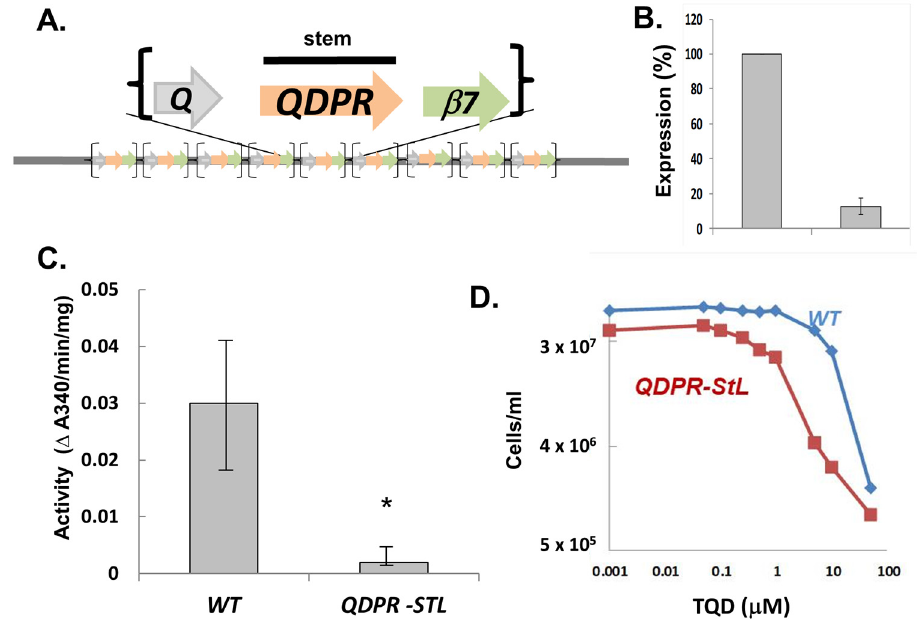
Figure 3. RNAi of the tandemly dispersed gene QDPR .( A ) QDPR gene organization in L. braziliensis . QDPR genes are tandemly repeated with ORFq ( Q ) and β 7 proteasome ( β 7 ) up to 9 times in L. braziliensis genomes; only the ORFs are depicted, and the entire QDPR ORF was used as the tested stem. Proteasome subunits are known to be essential, while the requirement for ORFq has not been tested. ( B ) QDPR protein expression in QDPR -StL knockdowns. QDPR was detected with anti-QDPR antiserum and expression was calculated relative to that of H2A, from Western blots as described in the methods. ( C ) QDPR enzymatic activity in QDPR -StL knockdowns. QDPR enzymatic activity was assayed and normalized to total cellular protein. Data were from three independent experiments each performed in triplicate. * indicates p < 0.0235. ( D ) Growth inhibition by inhibitor TQD. WT and QDPR -StL transfected Lbr were inoculated into media containing 0–50 µ M 5, 6, 7, 8-Tetrahydro-2, 4-quinazolinediamine (TQD) at 2 × 10 5 cells/mL and allowed to grow until WT had reached late log phase, at which time parasite numbers were determined. The experiment was repeated three times, with results similar to that shown; the EC50s for the QDPR -StL (red) and WT (blue) lines were 0.15 ± 0.015 vs. 3.49 ± 0.59 μ M ( p < 0.0006).